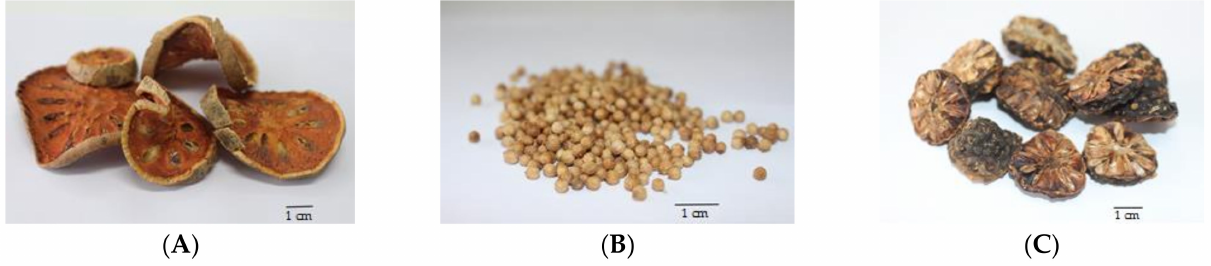
Figure 1. Macroscopic characteristics of crude drugs. ( A ) Fruits of Aegle marmelos (L.) Corr ê a; ( B ) fruits of Coriandrum sativum L.; and ( C ) Fruits of Morinda citrifolia